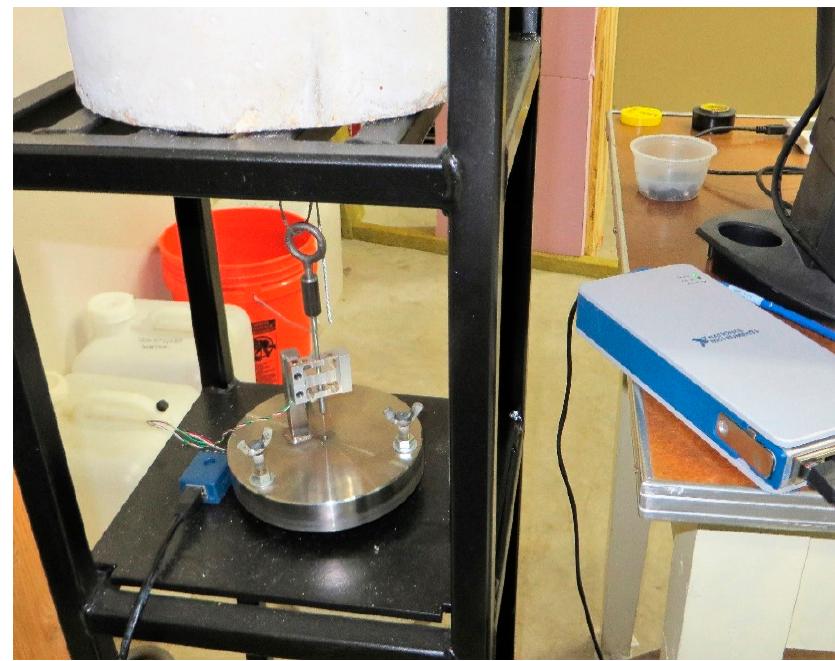
Figure 4. Photograph of load cell on support table with counterweight above.